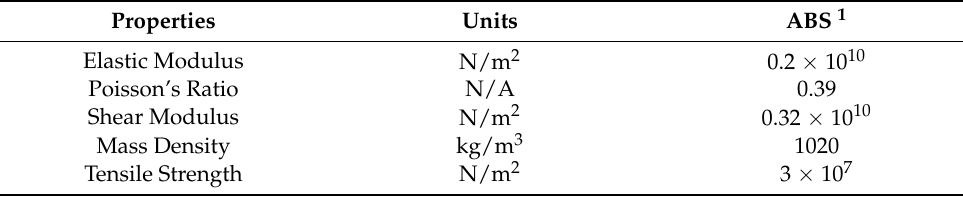
Table 2. Material characteristics of the ABS (Acrylonitrile Butadiene Styrene)